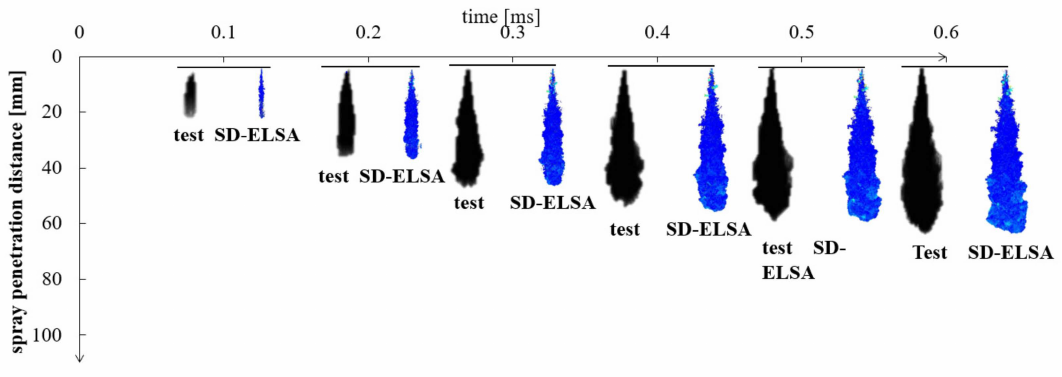
Figure 6. Diesel spray process. ( p injection = 100 MPa, p b = 1 MPa).